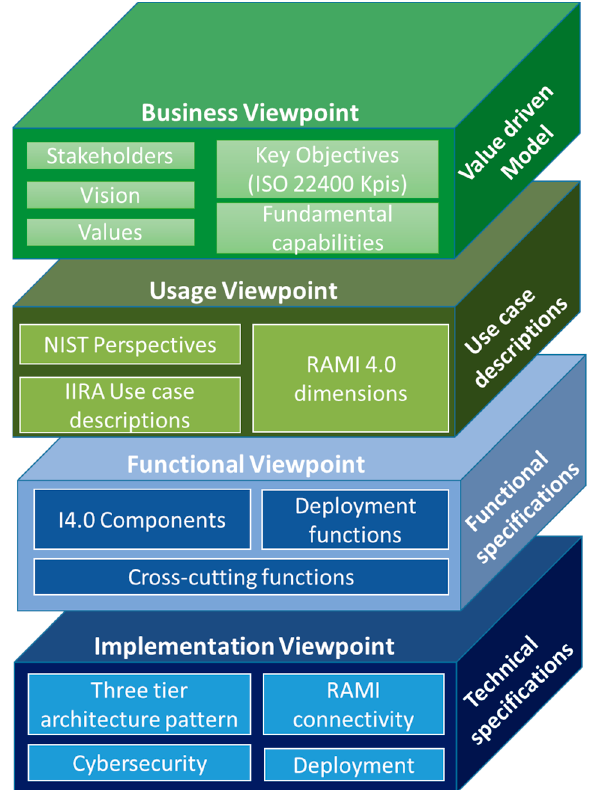
Figure 8. Industrial Internet Integrated Reference Model (I3RM).